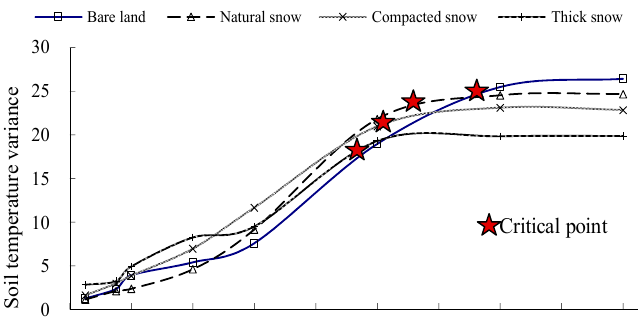
Figure 6. Variation in the soil temperature variance.